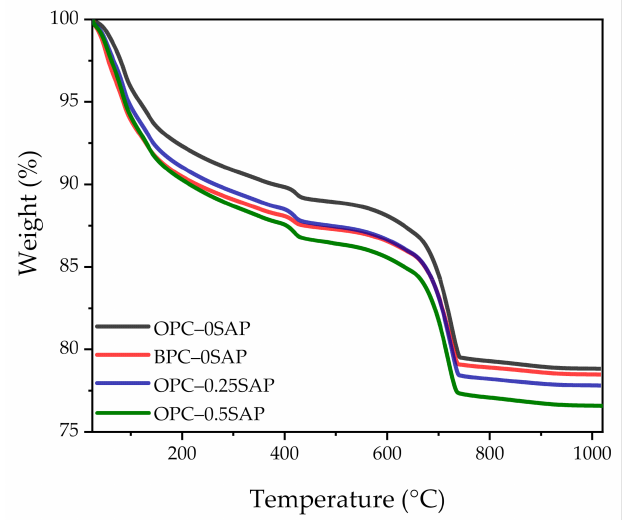
Figure 12. Thermogravimetric analysis (TGA) curves of all